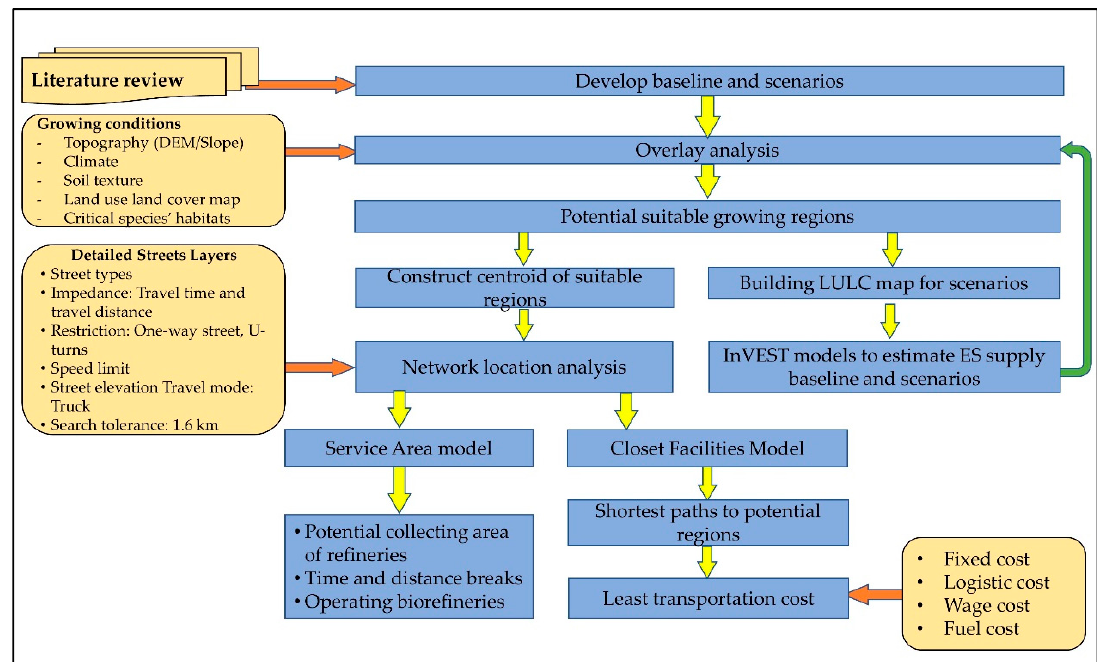
Figure 1. Conceptual research framework.